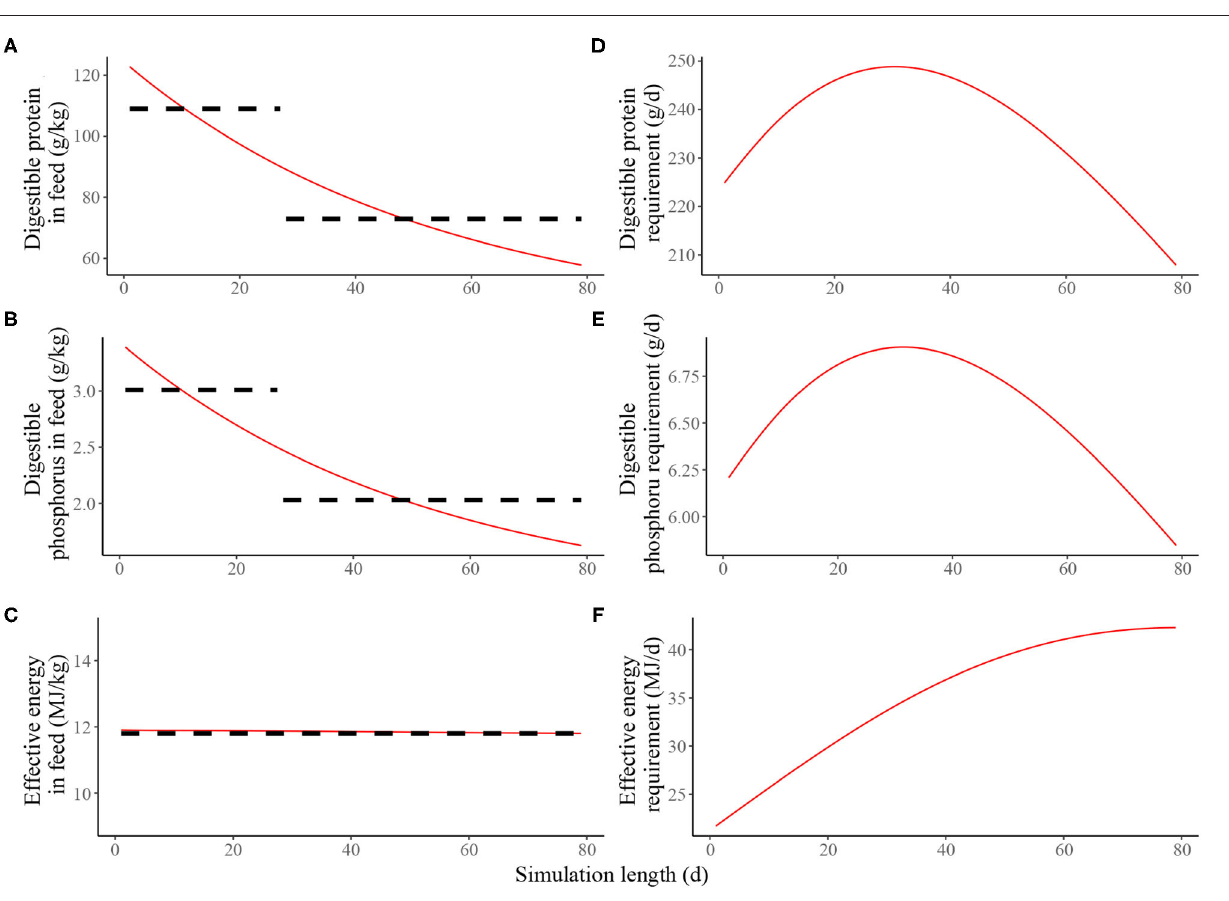
FIGURE 2 | Estimated nutritional composition of the feeds in either two-phase feeding strategy (dashed black line, Scenario 1) or precision feeding strategy (solid red line; Scenario 2) offered to the average pig in terms of: (A) digestible protein (g/kg); (B) digestible phosphorus (g/kg); (C) effective energy (MJ/kg); estimated daily nutrient requirement for maintenance and growth of the average pig in terms of: (D) digestible protein (g/d); (E) digestible phosphorus (g/d); (F) effective energy (MJ/d). For a detailed description of the simulated scenarios, see section Simulated Feeding